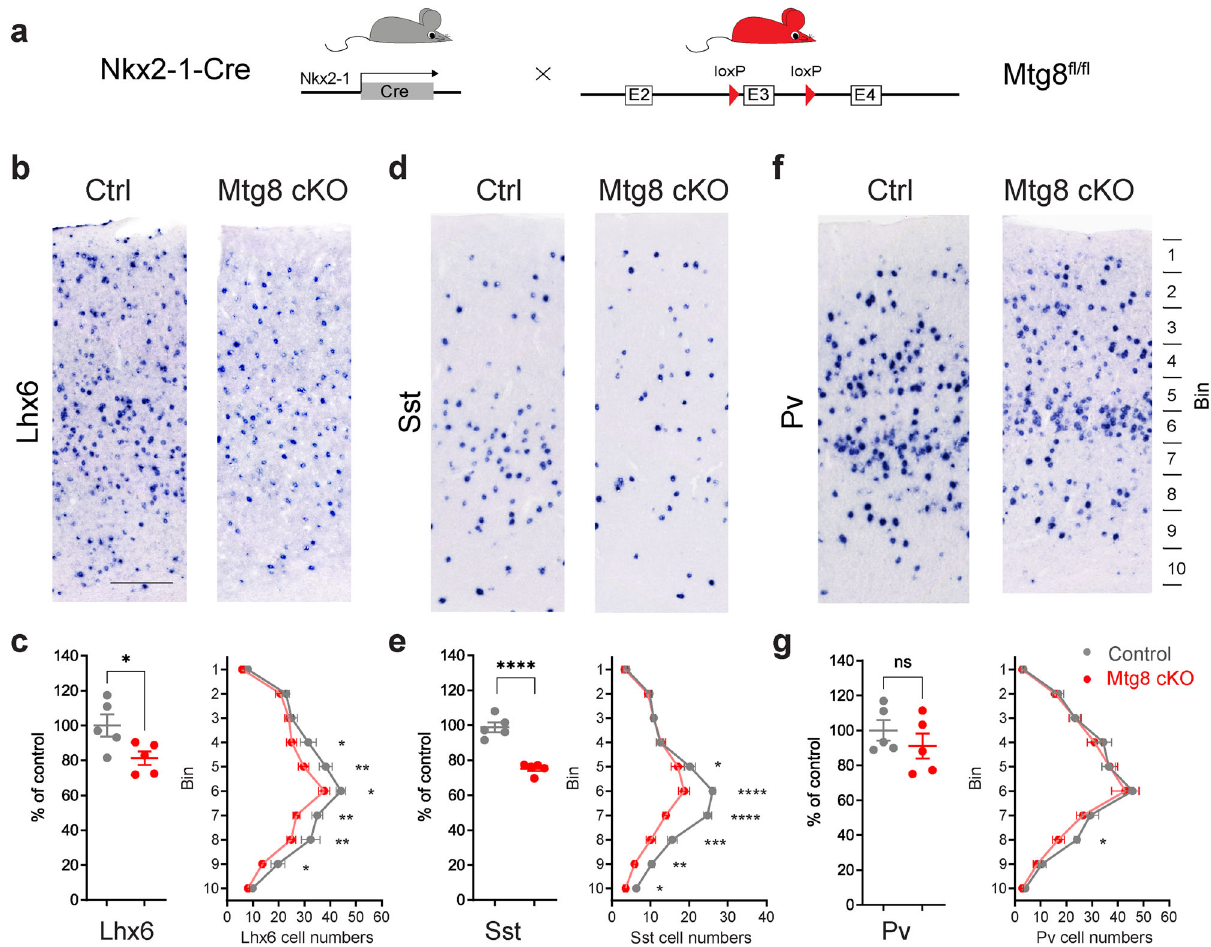
Fig. 7 | Mtg8 is required for speci fi cation of cortical SST interneuron subsets. a Strategy for the generation of Mtg8 conditionalmutantanimalsinthe MGE using Nkx2-1Cre. b – g RNAinsituhybridizationdetecting Lhx6,Sst and Pv inthecortexof Ctrland Mtg8 cKOanimalsatP40( b , d , f )andquanti fi cationoftotalnumbersandin different bins along the dorso-ventral extent of the somatosensory cortex ( c , e , g ). n =5 brains per genotype. Total numbers: two-tailed unpaired t tests. Lhx6